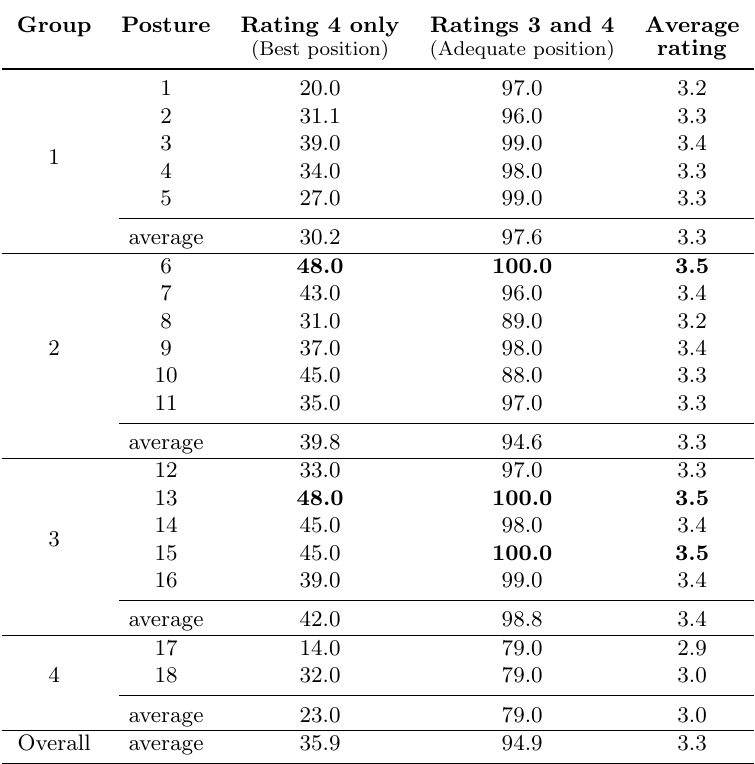
Table 3. The percentage of user judgments that fit into “best position” and “adequate position” [%]. Also, average ratings are shown. Group Posture Rating 4 only